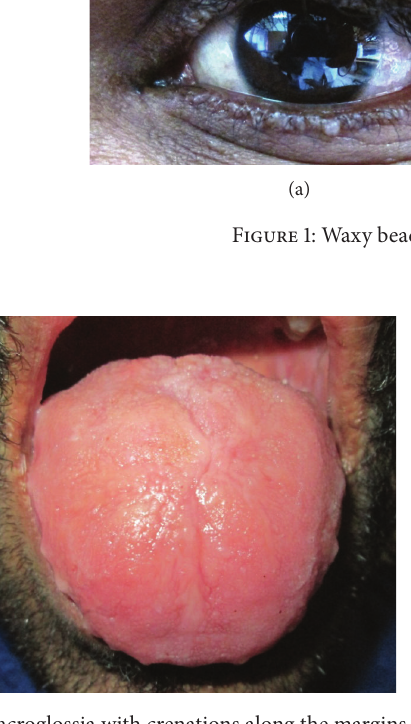
Figure 2: Macroglossia with crenations along the margins and loss of papillae on dorsum surface of the tongue.